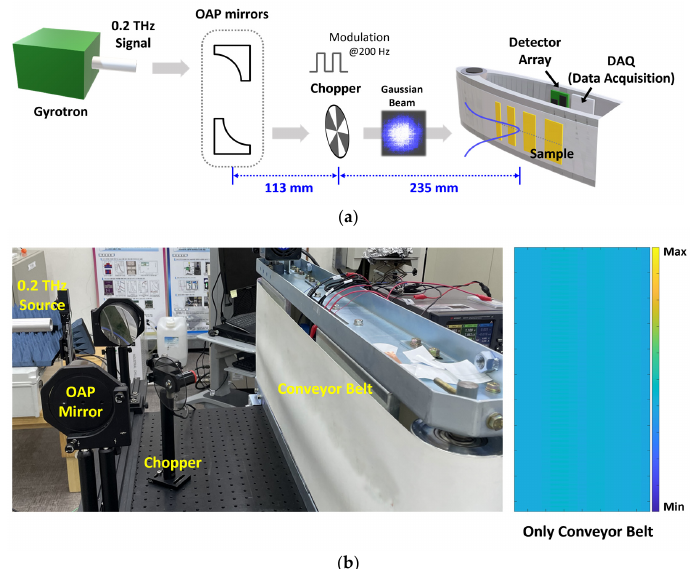
Figure 14. Experimental setup for measuring the sub-terahertz images using the proposed CMOS detector array: ( a ) Block diagram of the setup. ( b ) Photo of the setup and the measured image when there is no object on the conveyor belt.